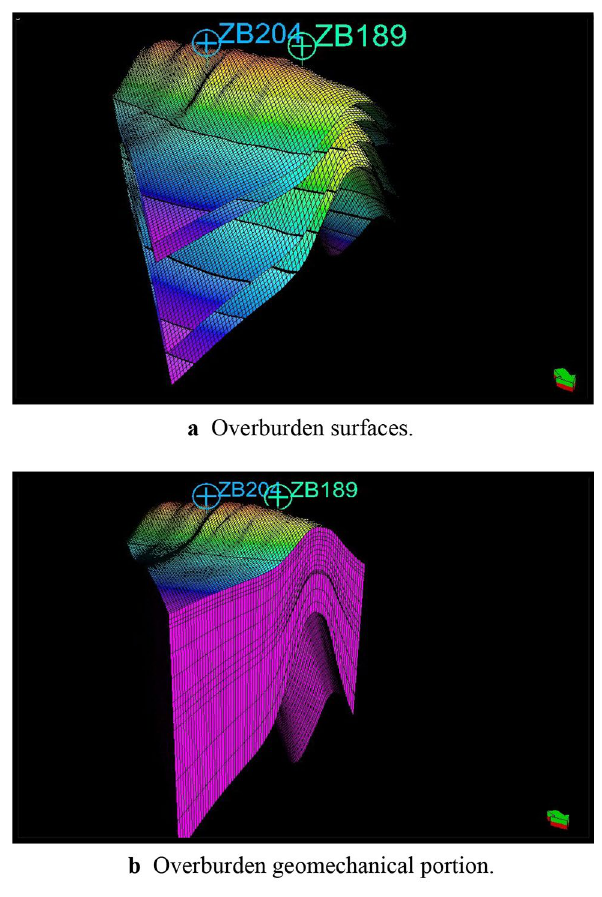
Fig. 12 Overburden surfaces and overburden geomechanical